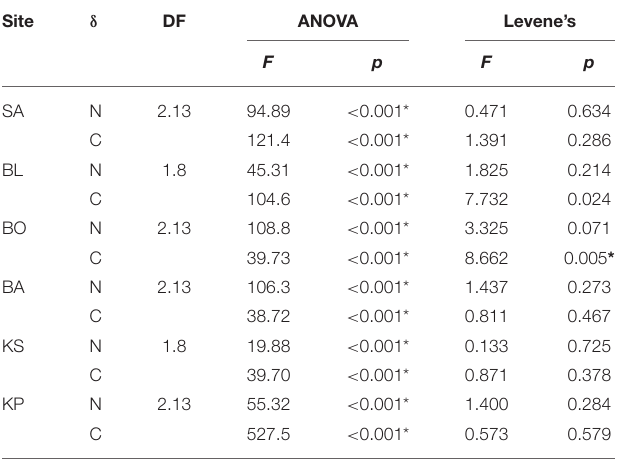
TABLE 2 | Differences in values (ANOVA) and variance (Levene’s test) of food sources within sampling sites. Site